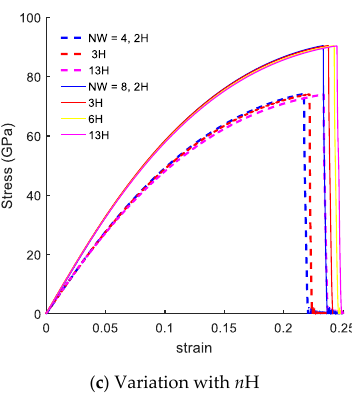
Figure 6. Stress–strain curves of ( a ) Cove II, ( b ) Cove III and ( c ) for different n H values.